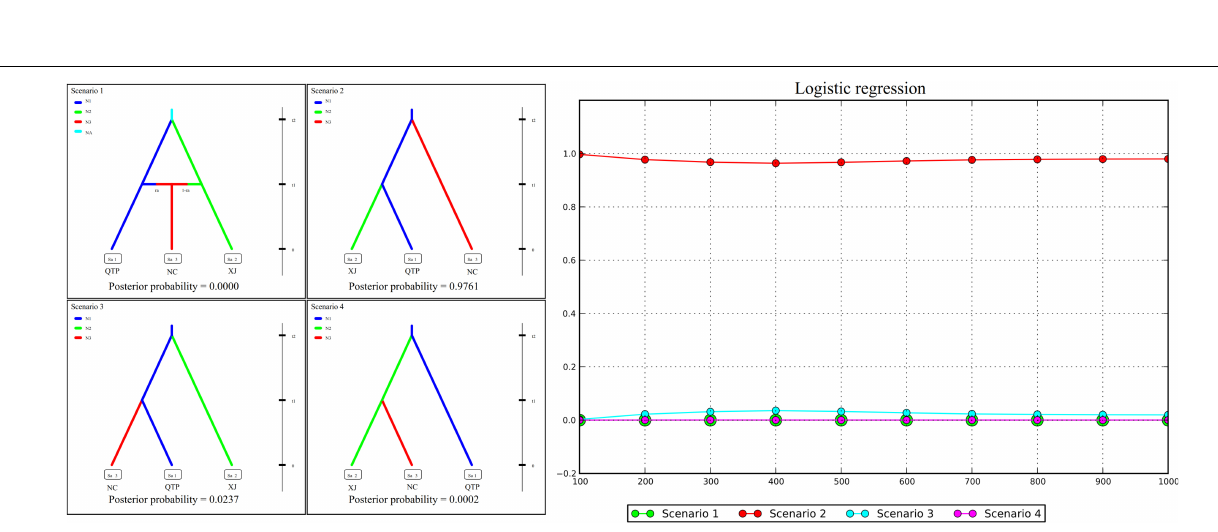
Frontiers in Plant Science |